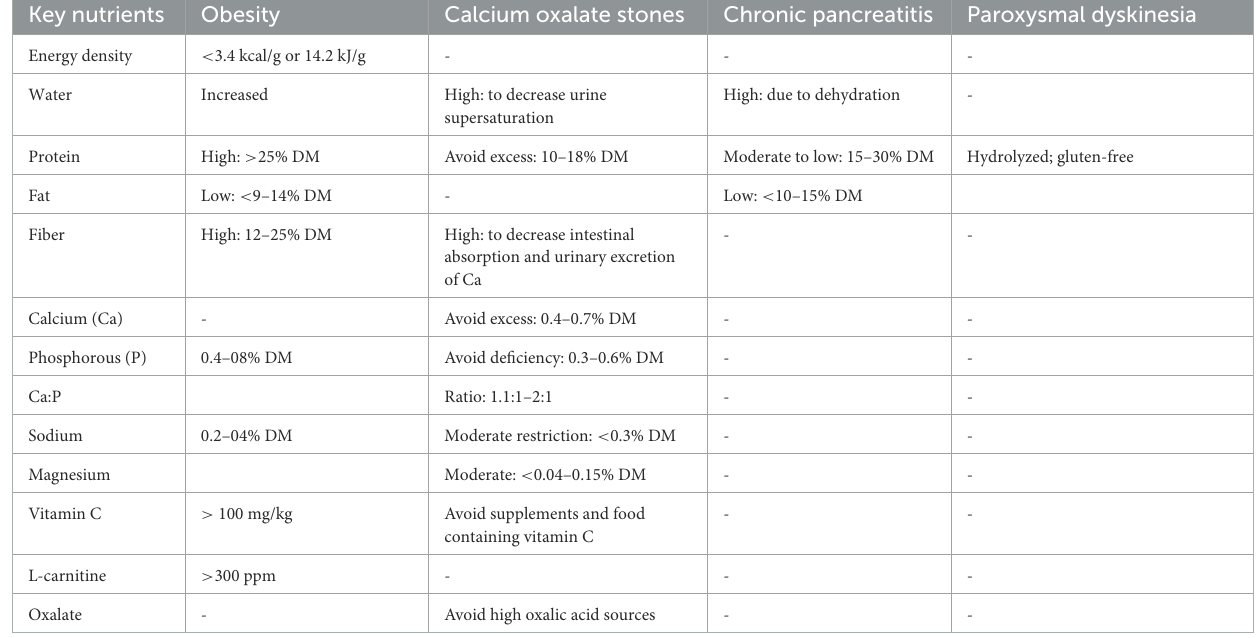
TABLE 3 Key nutrients and their aimed values for the associated